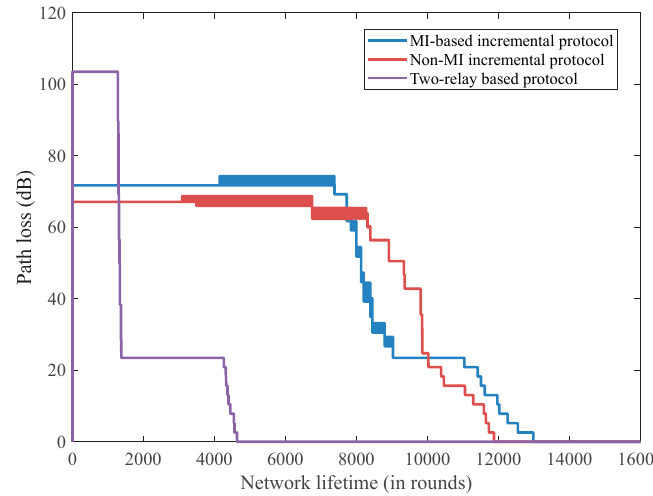
Figure 5. The residual network energy versus the network lifetime. Sensors 2018 , 18 , x